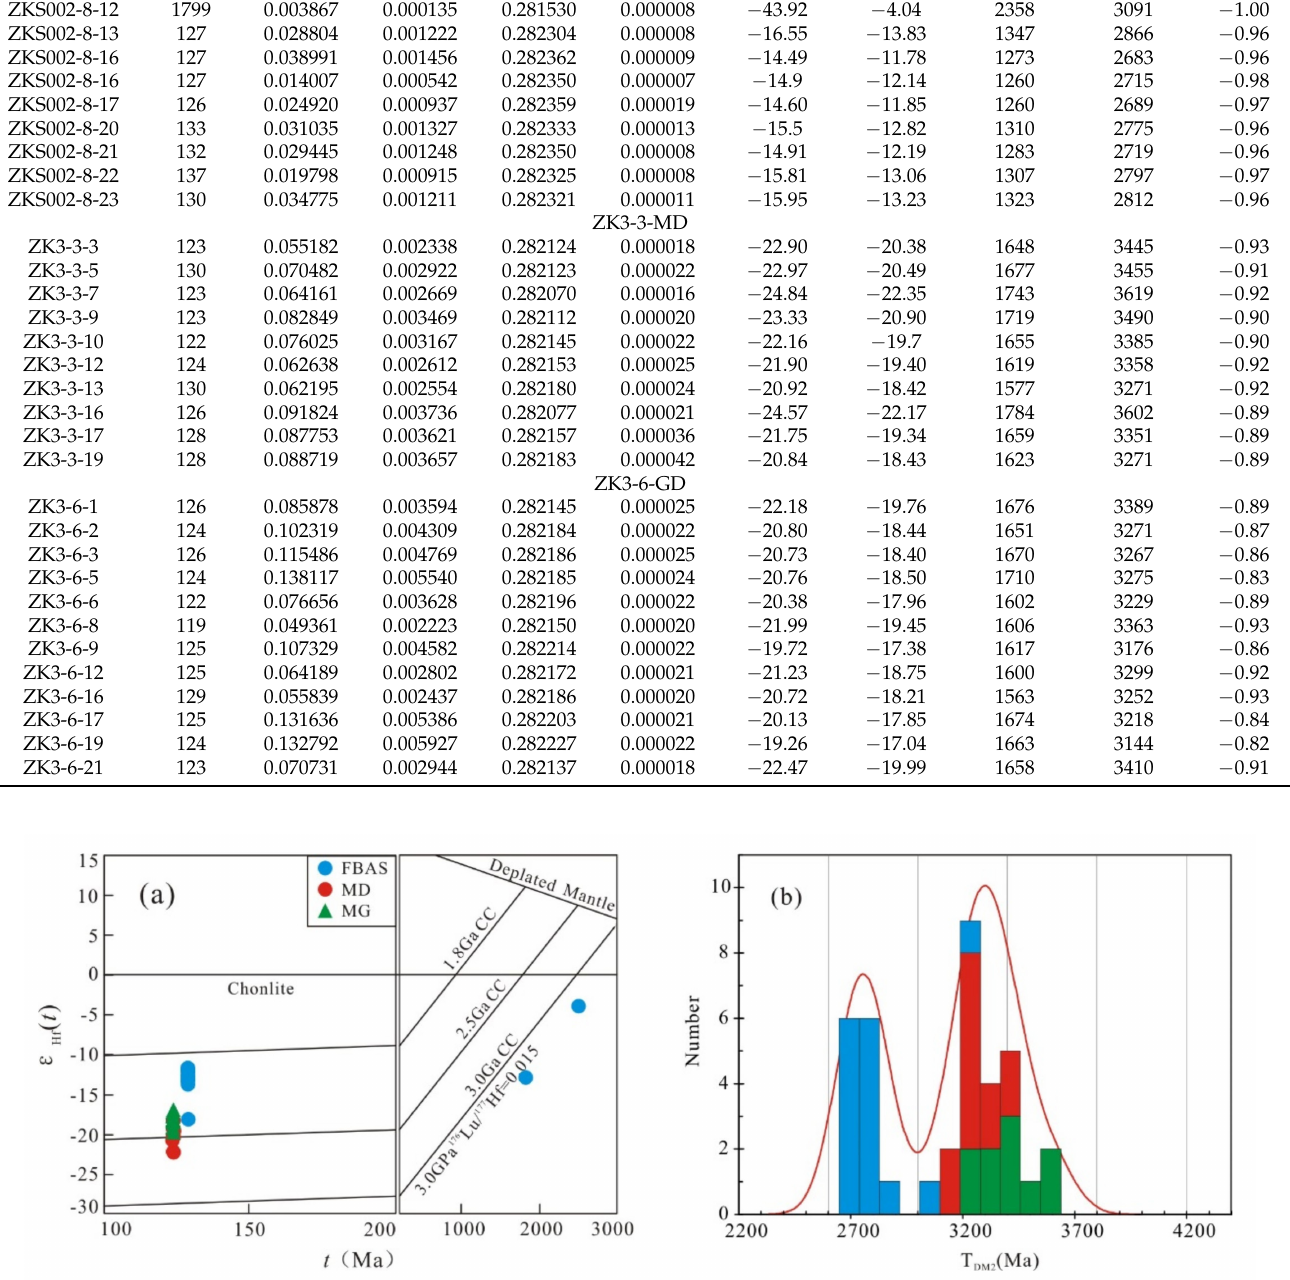
Figure 10. ( a ) ε Hf(t) versus crystallization age of zircons from the Hongshan complex [50]; ( b ) Frequency distributions of the T DM2 of zircons from the Hongshan